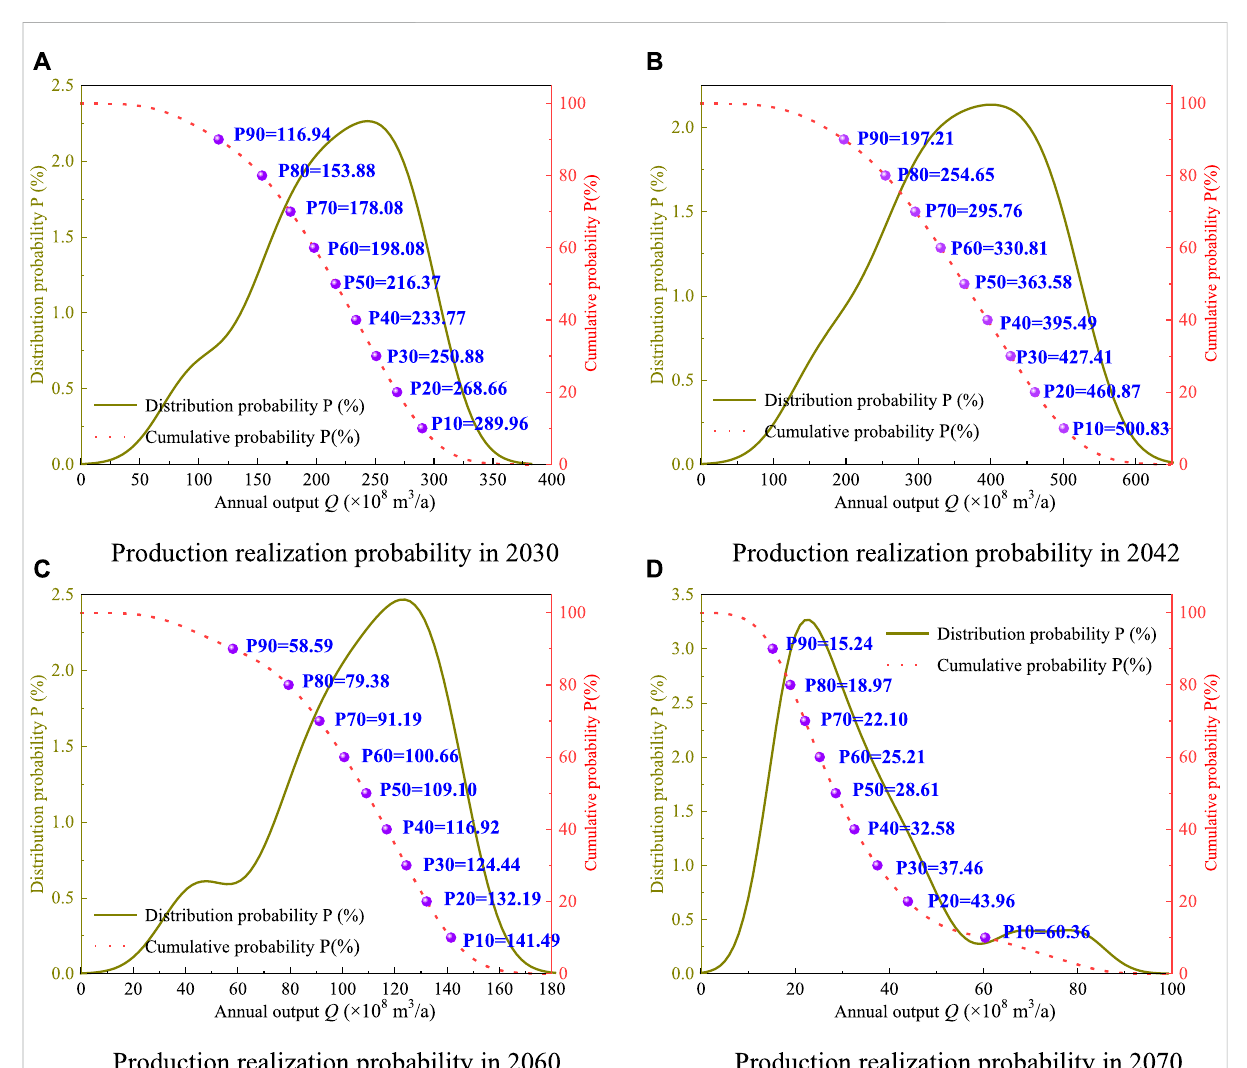
FIGURE 9 Yield realization probability calculation in different years. (A) Production realization probability in 2030. (B) Production realization probability in 2042. (C) Production realization probability in 2060. (D) Production realization probability in 2070.